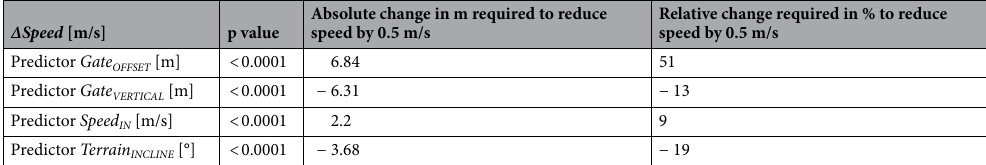
Table 2. Results showing what change in each predictor is needed to cause a reduction in speed ( ∆Speed ) of − 0.5 m/. The underlying analysis for these results is provided in the supplementary material in Tables 4 and 5.